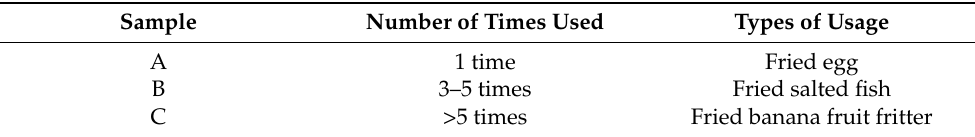
Table 1. Sample of waste cooking oil and the number of times used before treatment.